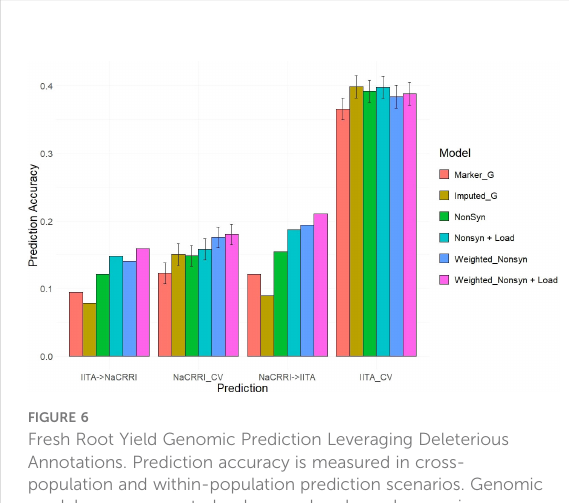
FIGURE 6 Fresh Root Yield Genomic Prediction Leveraging Deleterious Annotations. Prediction accuracy is measured in cross- population and within-population prediction scenarios. Genomic models are represented as bar graph colors where various genomic and deleterious data are used in the genomic prediction. Error bars represent a 95% con fi dence interval for within-population 10-fold